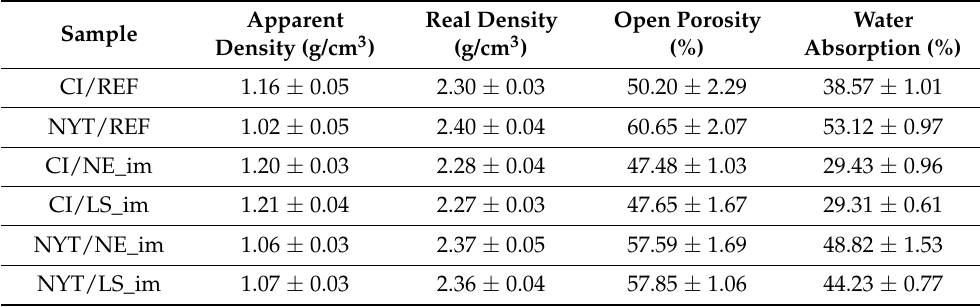
Table 4. Main physical properties of tuff stones before and after consolidating treatments, carried out on at least six samples (average values ± standard deviation are reported).